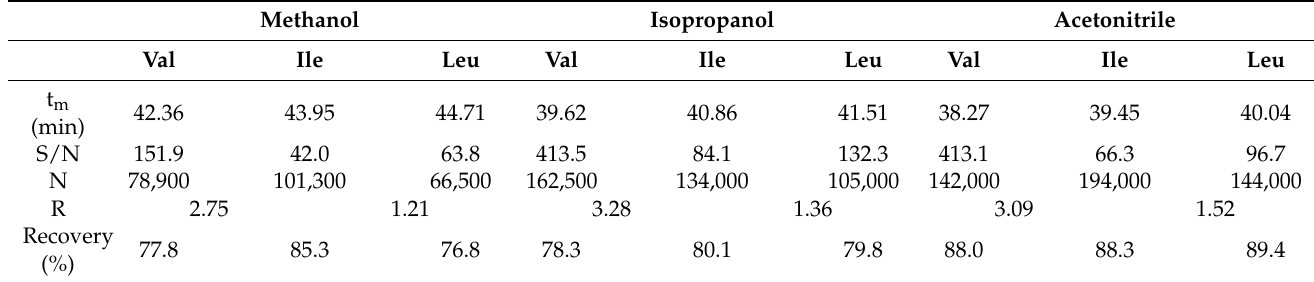
Table 5. Effect of the precipitation agent on the plasma sample preparation for BCAA analysis.